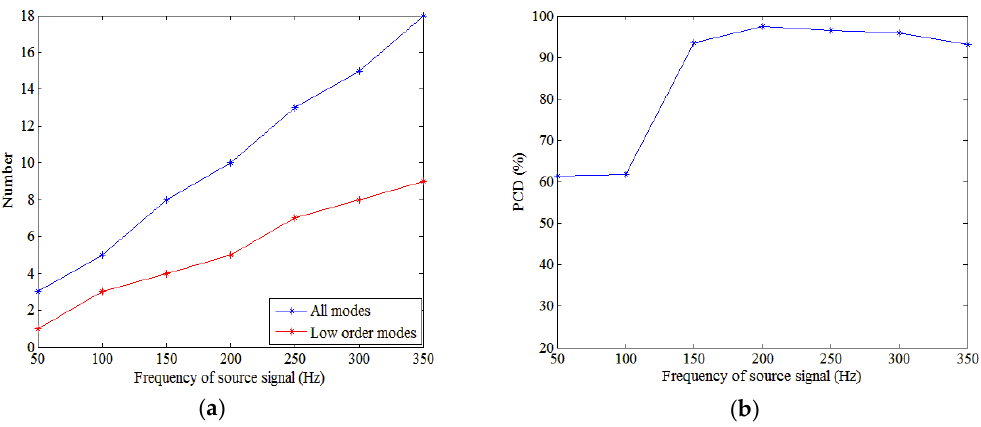
Figure 12. Number of modes and performance evolution with the source frequency. ( a ) Numbers of all propagative modes (blue) and low-order modes (red) versus frequency. ( b ) PCD versus the frequency of the source signal.